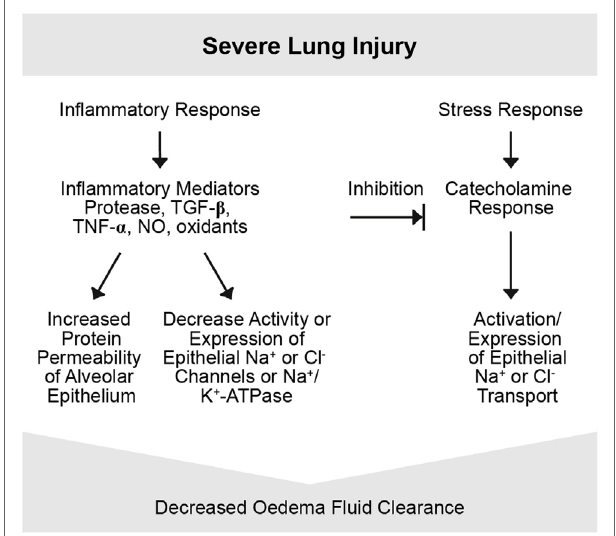
FigURe 4 | Severe lung injury. Severe lung injury may usually lead to decreased edema clearance. Severe injury usually includes alveolar epithelial injury and, thus, increases epithelial permeability and electrolytes and is associated with reduced epithelial Na + transport. Inflammatory mediators are involved in this response, such as proteases, tumor necrosis factor (TNF), TGF- β , nitric oxide (NO), and oxidants. Possibly the intensity of the inflammatory response may transform a mild to a severe lung injury form by inducing changes in function and integrity of the alveolar epithelium and endothelium (4).